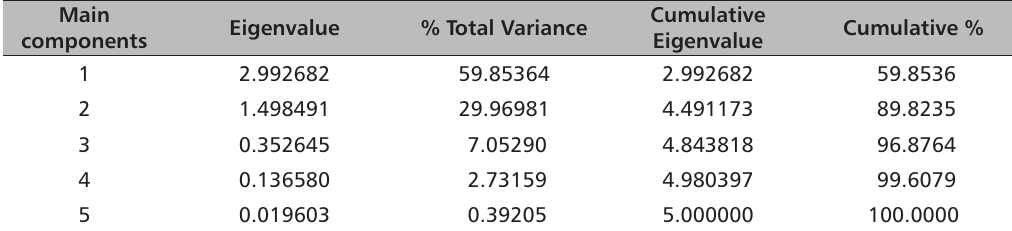
taBle 5. Eigenvalues, the percent of variance and cumulative variance